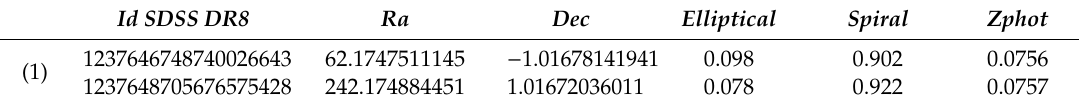
Table 7. The pair with the best positional accuracy for the e ff ect of cosmic mirror in catalog [41]. At Table 6. this pair has the best probability for both galaxies to be of spiral type. Id SDSS DR8—objID identification number in the Sloan Digital Sky Survey. Accuracy is of 0.00015 ◦ for ra and dec and 0.001 for zphot